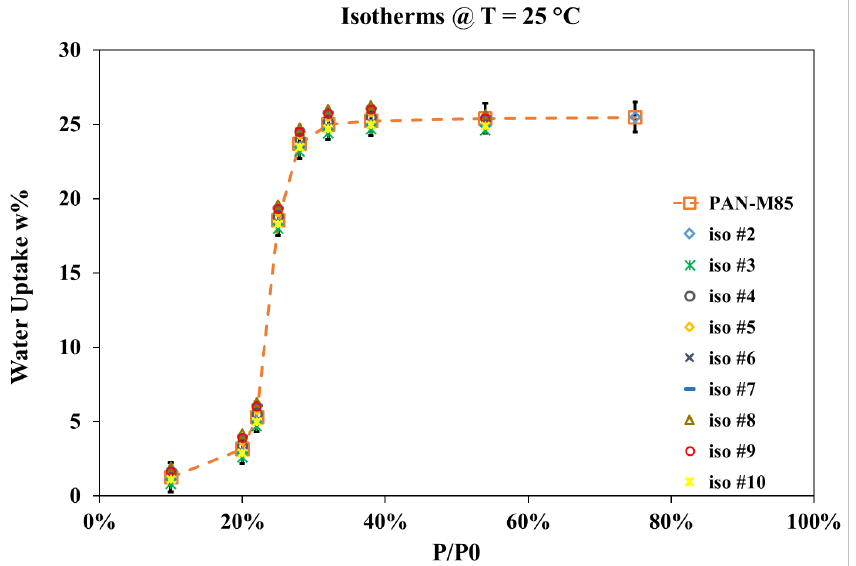
Figure 9. Cyclic test of adsorption isotherms.